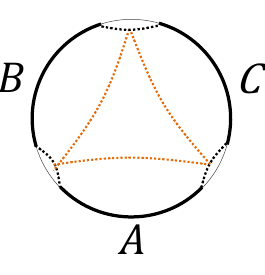
Figure 1 . An example of minimal surfaces which gives (cid:1) W for a tripartite